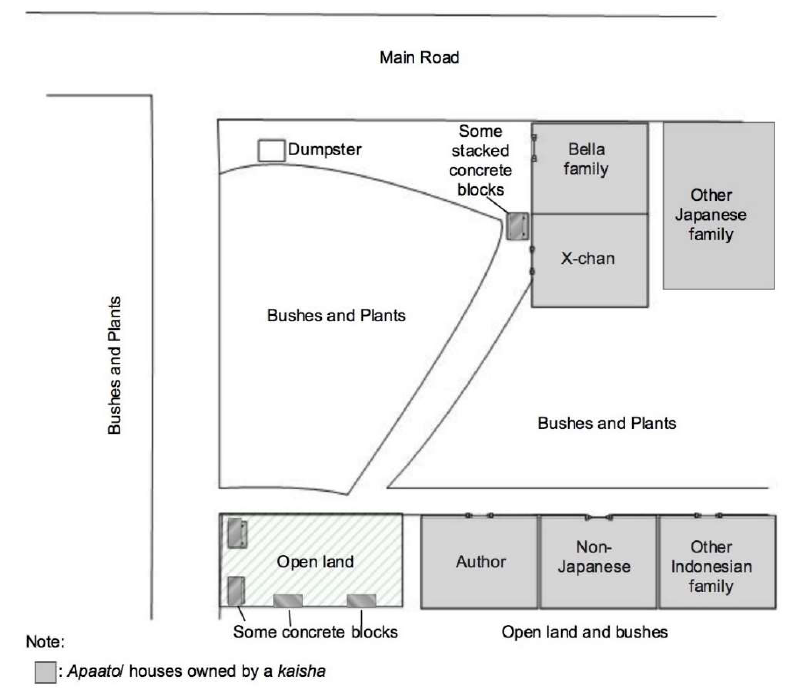
Figure 4. Illustrating map of the complex in the neighborhood (by author).